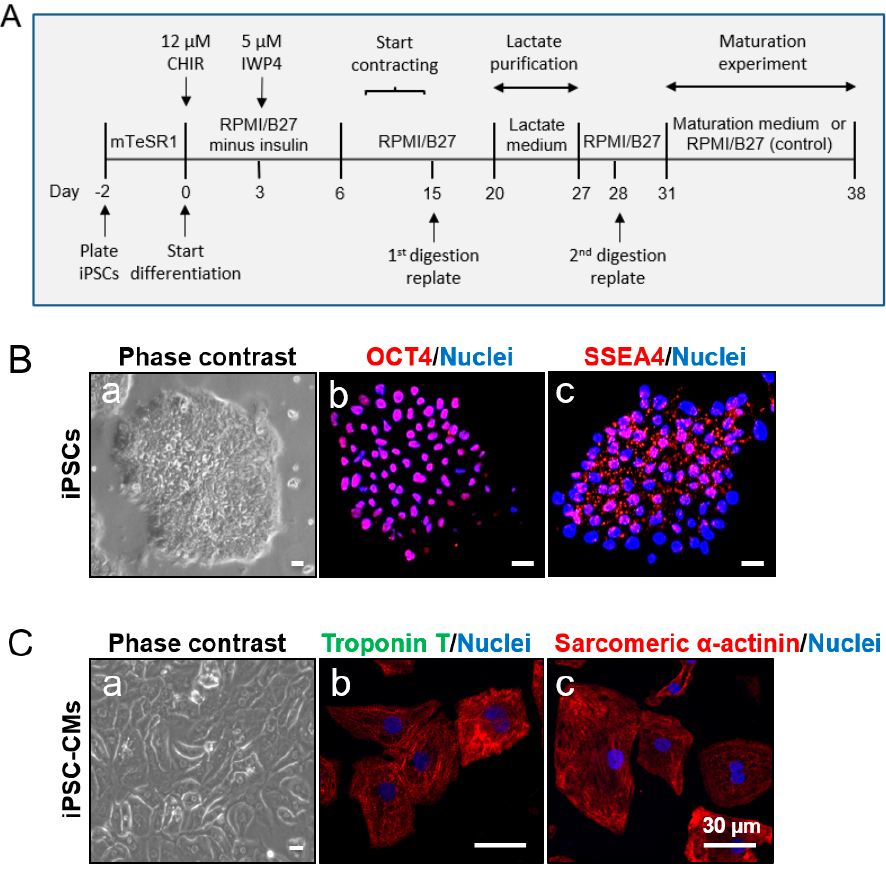
Figure 1. Characterization of human induced pluripotent stem cells (iPSCs) and iPSC-derived cardiomyocytes (iPSC-CMs). ( A ) Schematic depicting the procedure for the generation of